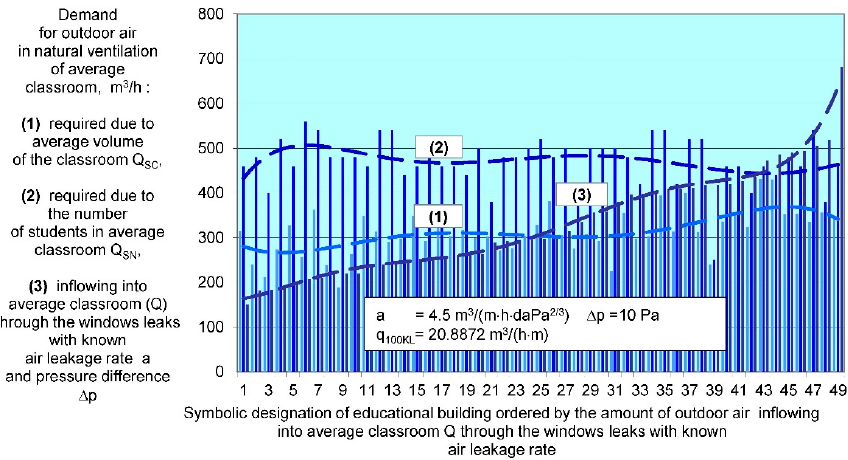
Figure 9. The quantity of air flowing into the classroom from the outside through draughty windows